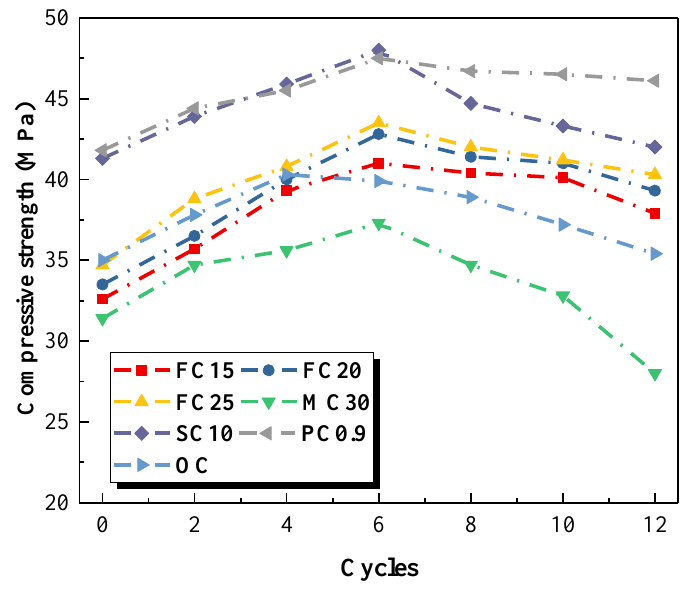
Figure 3. Compressive strength variation.